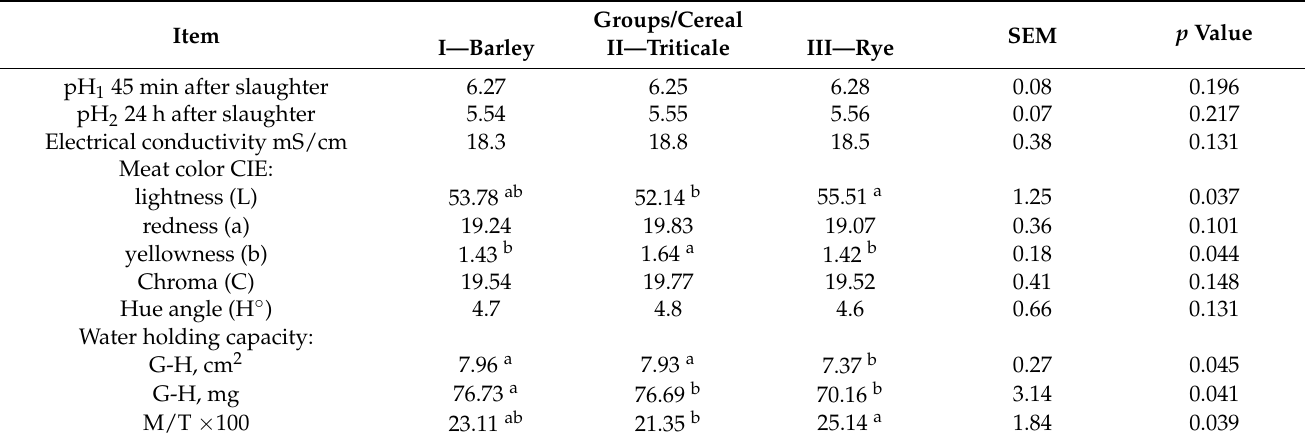
Table 7. Meat quality indices ( longissimus lumborum